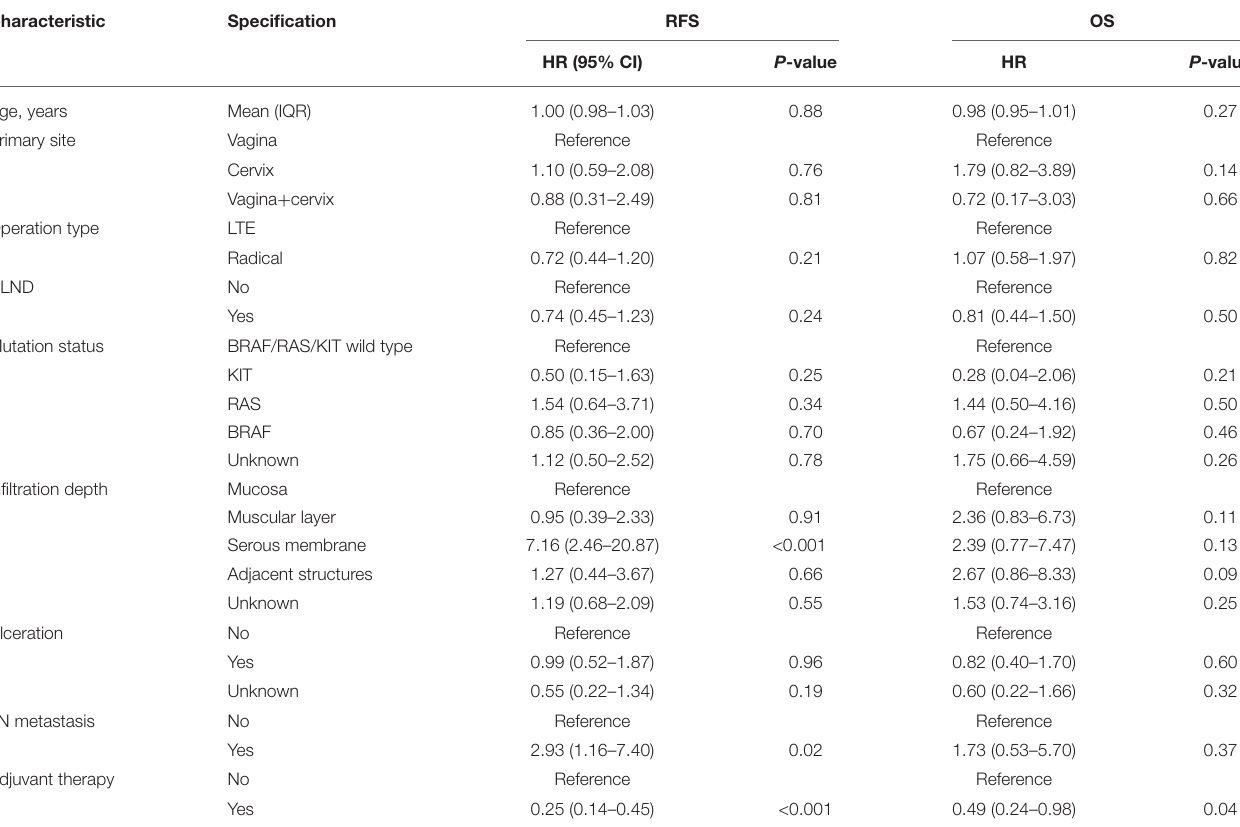
TABLE 2 | Results of univariate analyses of recurrence-free survival (RFS) and overall survival (OS).